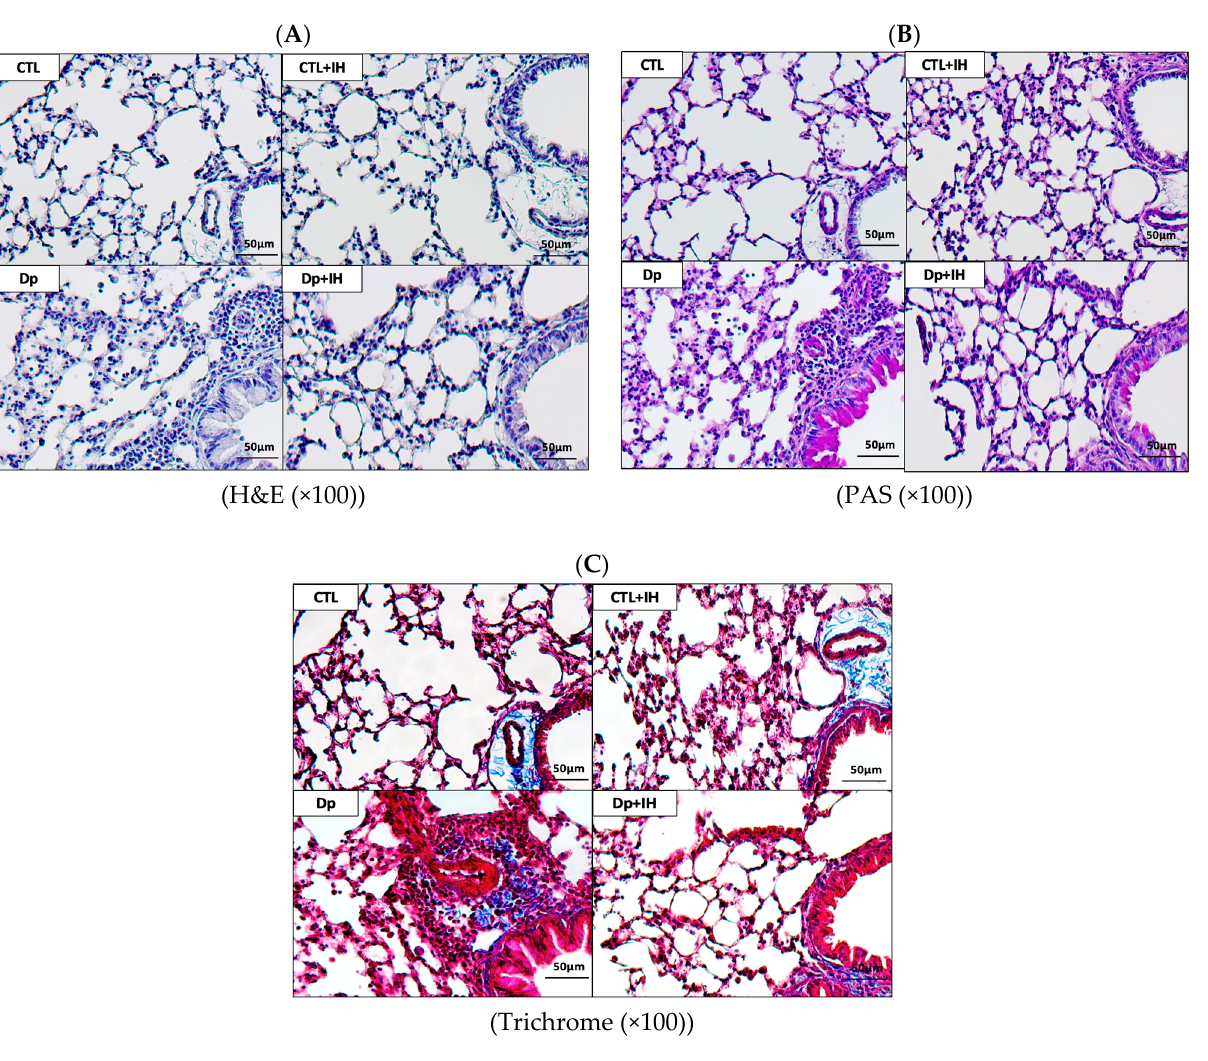
Figure 1. Comparison of histological changes in the lung after IH exposure. ( A ) Representative pictures of hematoxylin and eosin staining (100 × ) and ( B ) PAS staining (100 × ) ( C ) Masson’s trichrome staining (100 × ) of lung sections from mice after the final administration of Dp. Scale bars, 50 µ m. Sections are representative of seven mice. CTL: control, saline challenge under normoxia conditions, CTL+IH: IH exposure without Dp administration Dp: Dp administration for allergic asthma induc-